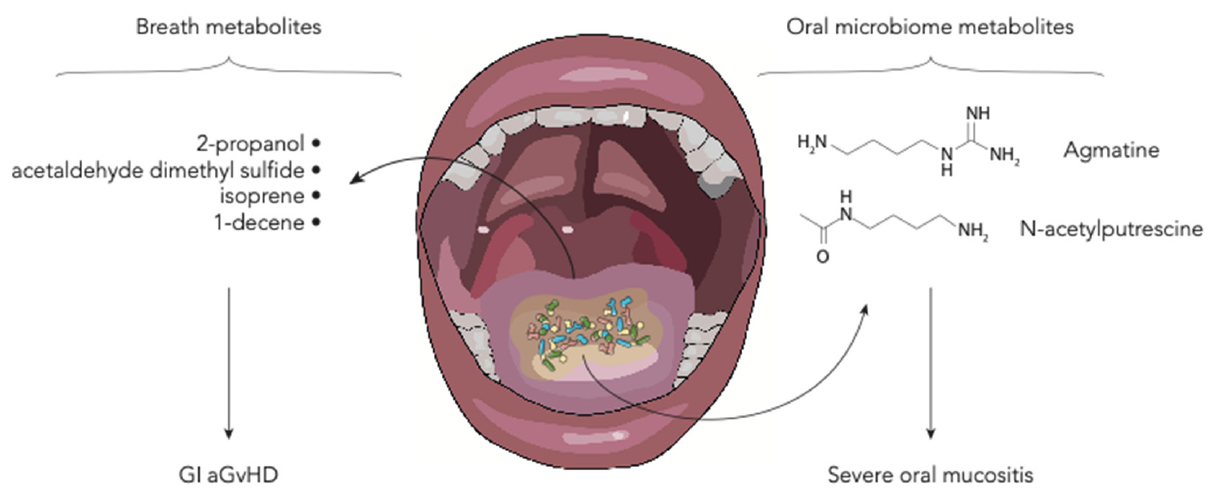
Figure 3. Schematic representation of the oral and breath metabolites in the allo-HSCT setting (aGvHD—acute graft-vs-host disease; GI—gastrointestinal).